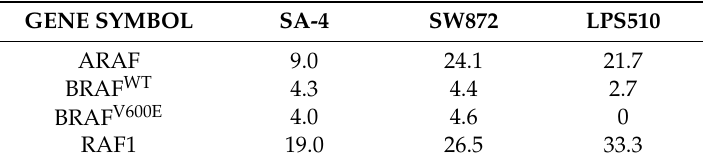
Table 1. mRNA expression.